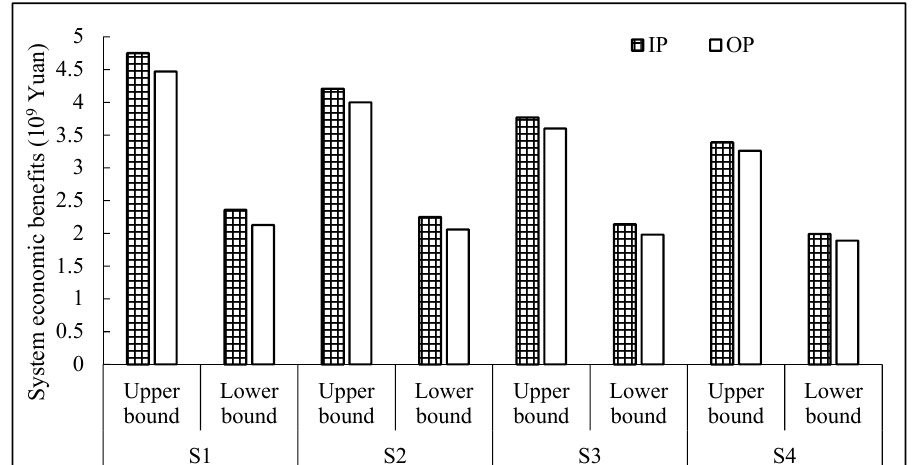
Figure 5. Economic benefits comparison based on the original plan (OP) and improved plan (IP) under different scenarios.